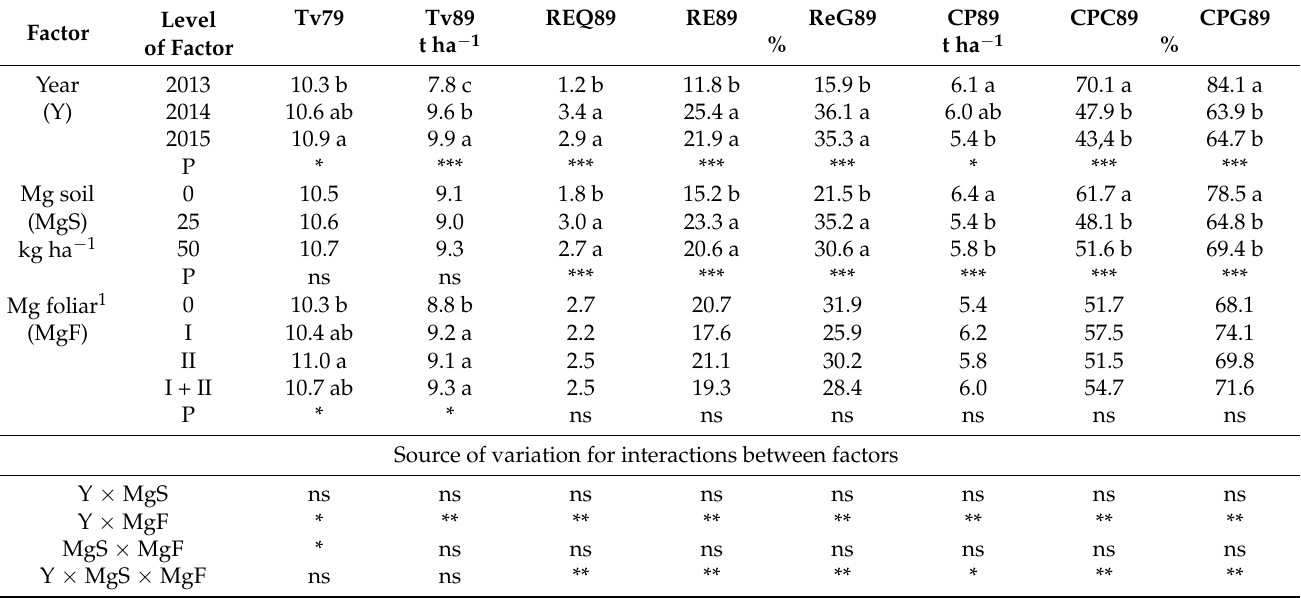
Table 5. Indices of winter wheat biomass partitioning during the grain-filling